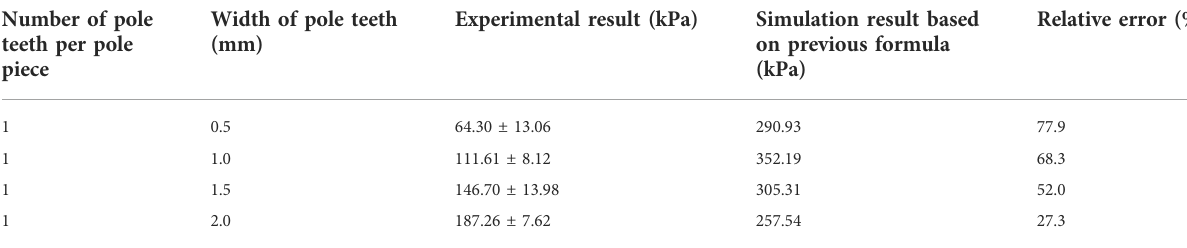
TABLE 2 Comparison between simulation based on previous formula and experimental results of different MP sealing structures. Number of pole teeth per pole